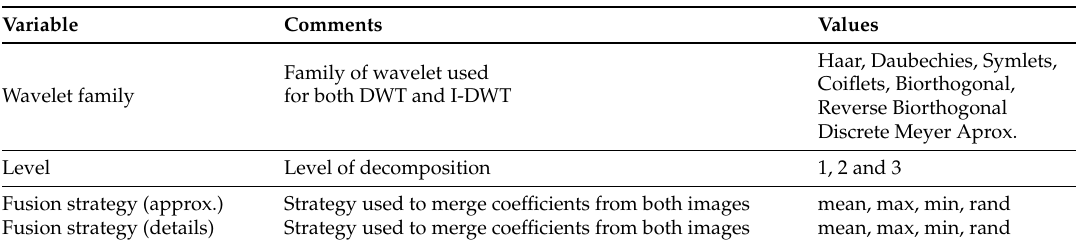
Table 1. Setups evaluated in the current